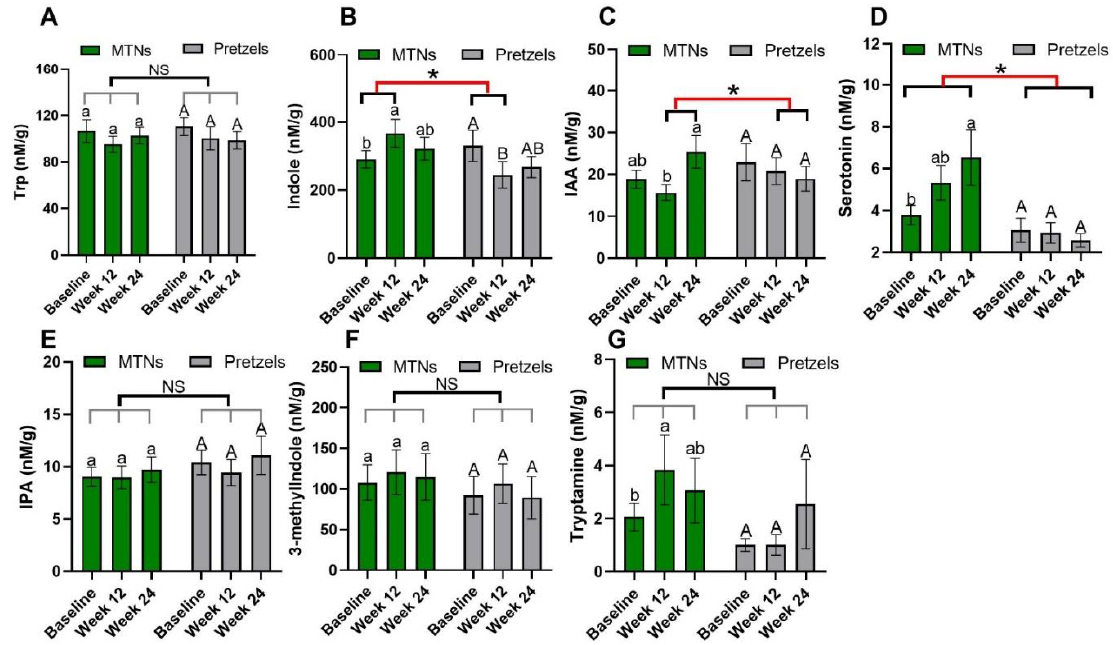
Figure 3. Levels of fecal Trp ( A ) and Trp metabolites, ( B ) KYN, ( C ) KYNA, ( D ) serotonin, ( E ) IS, ( F ) IAA, and ( G ) IPA at baseline, week 12, and week 24 in pretzel group ( n = 39) and MTNs group ( n = 56). The results are presented as mean values with SEM. For within-group analysis (lower case for MTNs; upper case for pretzels), means in a column without a common letter differ, p < 0.05. Changes from baseline were analyzed and between-groups difference is significant * when p < 0.05. NS, no significant difference between-groups